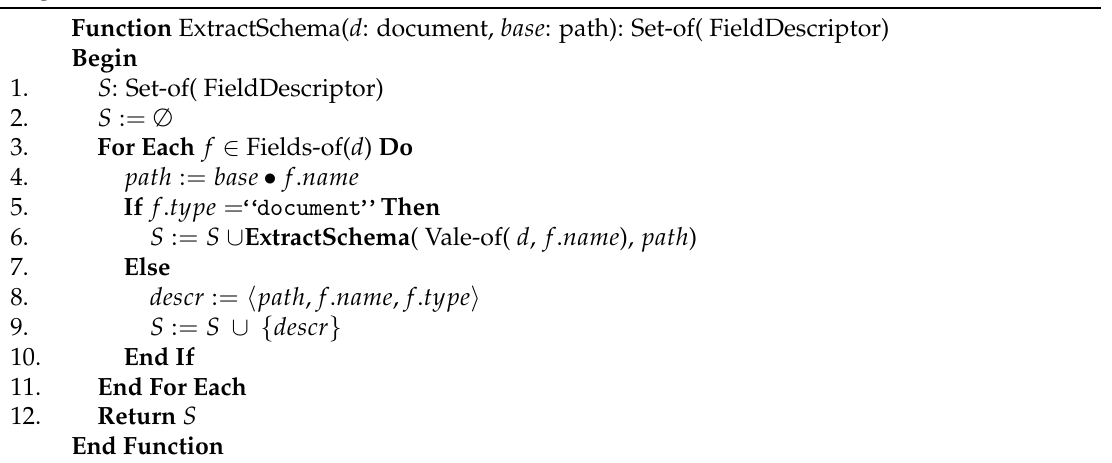
Algorithm 2: Function ExtractSchema